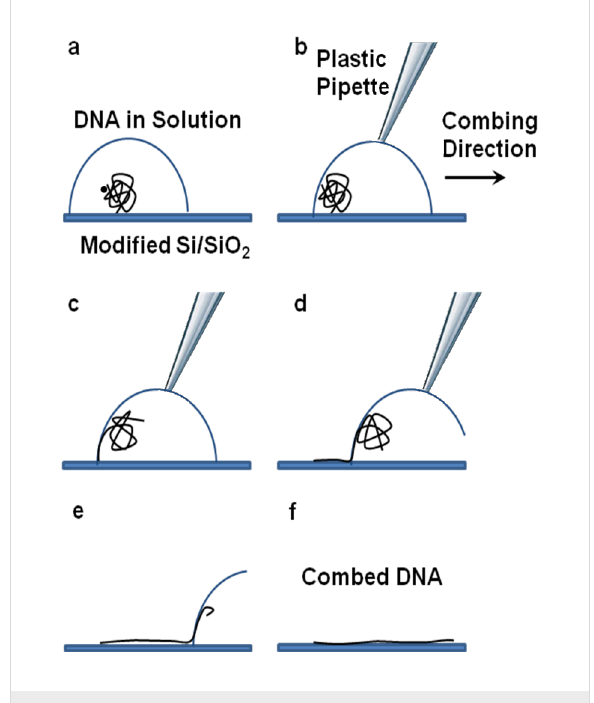
Figure 1: Schematic representation of the new combing method. The droplet containing the DNA solution makes contact angles of around 90° with the hydrophobic N -octyldimethylchlorosilane coated silicon surface. At pH 5.1 and ionic strength of 100 mM, DNA is adsorbed to the surface by the ends. By using a plastic pipette tip, the droplet is gently dragged out of the surface. The movement of the air–water interface results in the stretching of DNA molecules, which are fixed to the surface by one or both